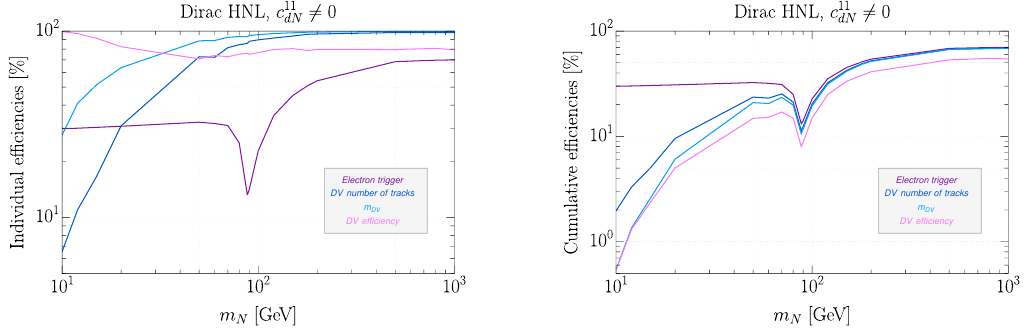
Figure 4 . ATLAS selection efficiencies as a function of the mass of a Dirac HNL, excluding the requirement of the DV fiducial volume. Here as a sample scenario, only one single operator O 11 switched on. The left (right) panel is for individual (cumulative) cut efficiencies. In the right plot, each line is for the cumulative efficiency assuming the given cut as well as the previous cut(s) if any.